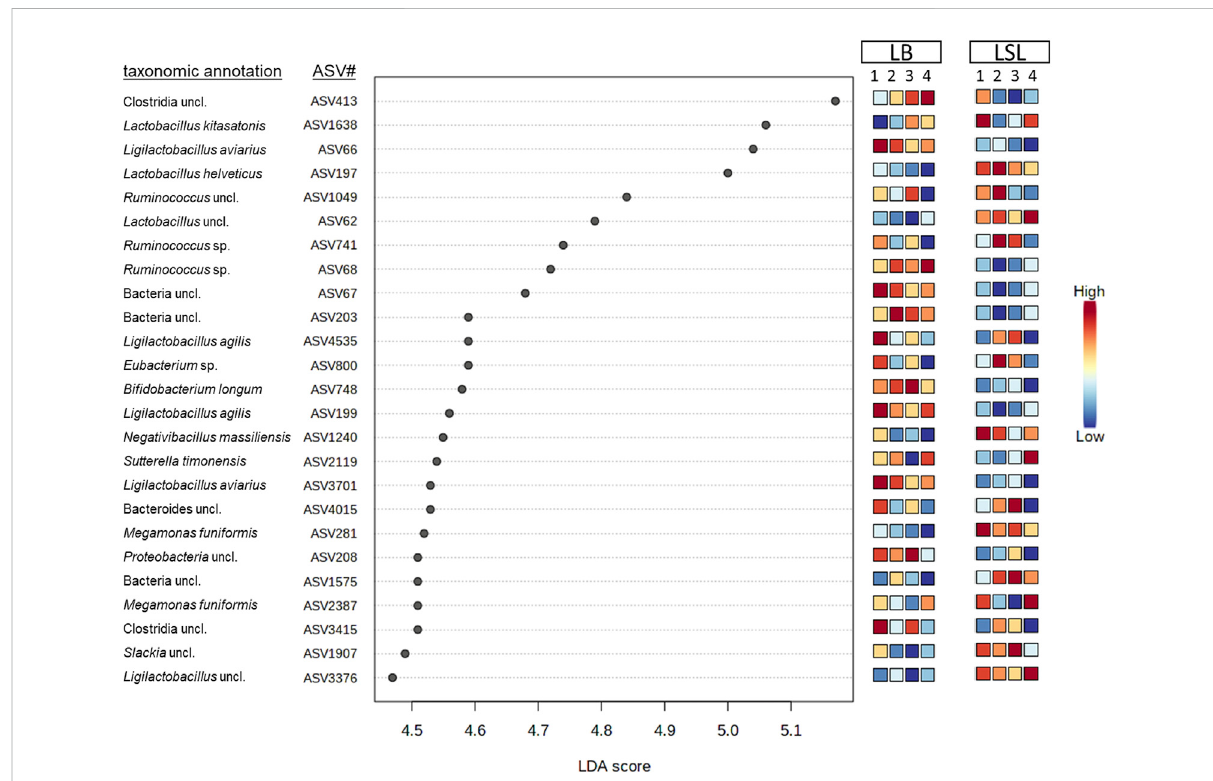
FIGURE 5 Discriminantanalysesofthe25mostsigni fi cantASVsincaecalsamplesbasedonaLEfSeanalysisshowingtheimpactperdiet(1:P + Ca + ,2:P - Ca - , 3: P + Ca - , 4: P - Ca + ) and breed. The scale indicates the relative abundance in comparison to the average across the eight groups consisting of both breeds and the four